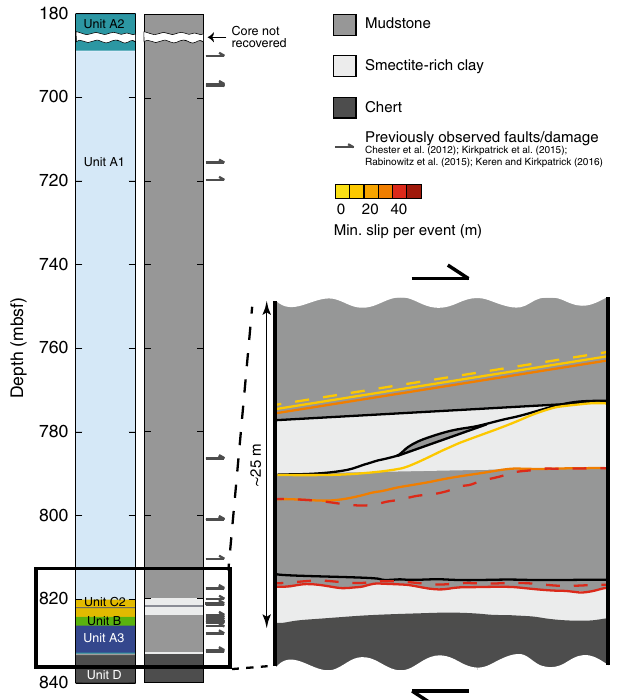
Fig. 4 Schematic of the structure recovered at JFAST 17, 18 . Trace element stratigraphy of the JFAST core is shown on the left with sedimentary units colored and labeled as in Fig. 1 17 . Generalized stratigraphy is shown in the middle with mudstone, smectite-rich clay, and chert lithologies indicated in different shades of gray. Previously observed faults and damage 17 – 19, 47 are indicated on the right side of the stratigraphic column. On the right, a zoomed-in schematic of the structure recovered at JFAST 17,18 is shown and faults with biomarker thermal anomalies are colored by the minimum slip magnitude capable of reproducing the observations within the allowable amount of total slip 13 . Dashed lines represent PP948, which was not modeled as well as samples PP944 and PP951 for which structural evidence is